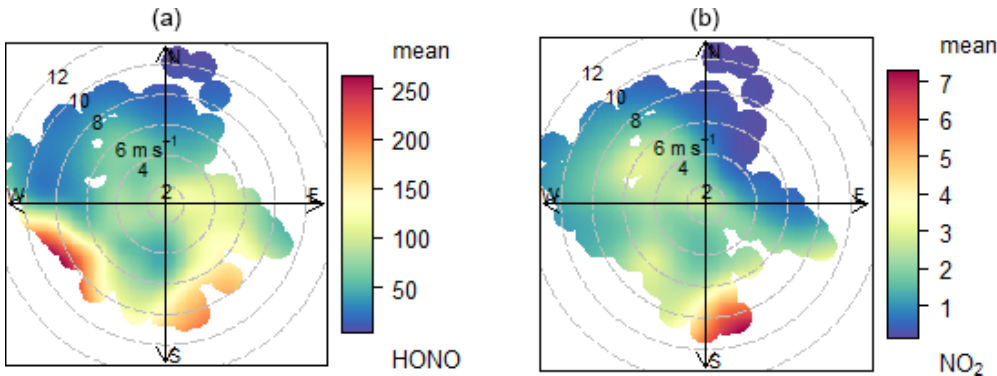
Figure 5. Polar plot of mean HONO ( a , ppt) and NO 2 ( b , ppb) mixing ratio for whole time series at WAO (marine + non-marine). The coast is towards the north of the measurement site.